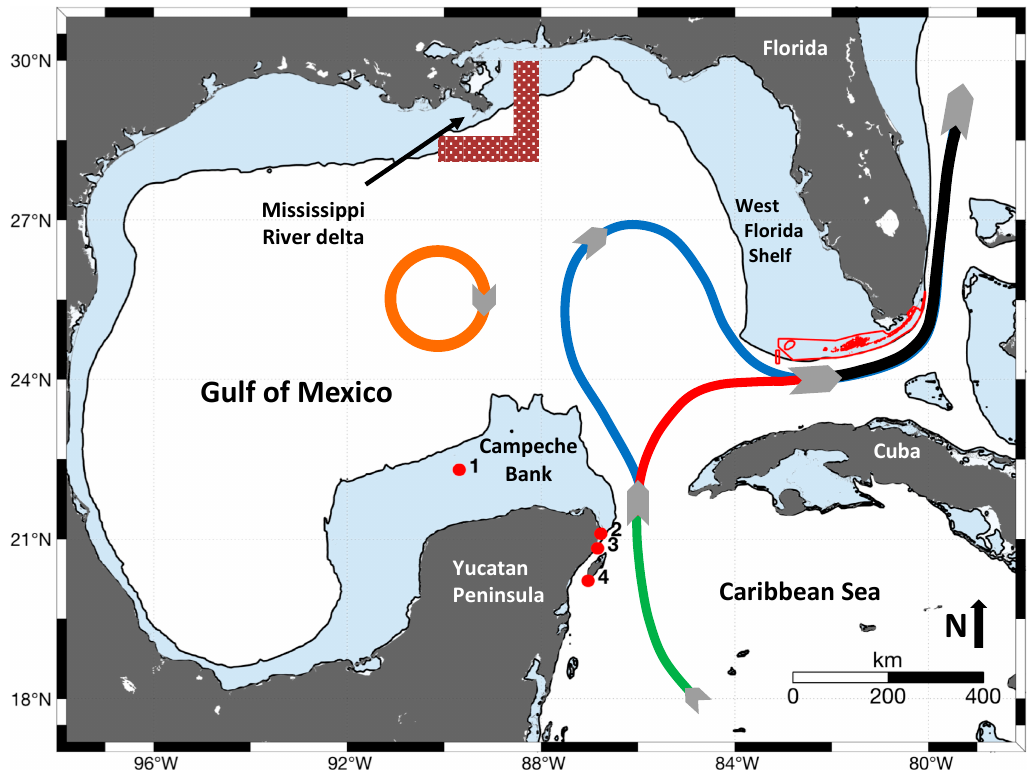
Figure 1. Map of the Gulf of Mexico and schematic of the Loop Current. The Gulf of Mexico Loop Current System enters the Gulf of Mexico as the Yucatan Current (green) and exits through the Florida Straits (black). The schematic represents two Loop Current states: a retracted state (red) and an extended state (blue). Loop Current Eddies (orange) are shed by the Loop Current while in its extended state. The maroon polygon at top center represents the area where chlorophyll-a values were extracted from satellite data to evaluate the frequency of offshore Mississippi River plume transport events. Depth contour line in black represents the 100m isobath. Areas with water depths less than 100 m are shaded in light blue. Marine protected areas of interest are shown by red circles: (1) Parque Nacional Arrecife Alacranes; (2) Parque Nacional Arrecife de Puerto Morelos; (3) Parque Nacional Costa Occidental de Isla Mujeres; and (4) Parque Nacional Arrecifes de Cozumel. The boundary of the Florida Keys National Marine Sanctuary is shown in red at the southern tip of the Florida